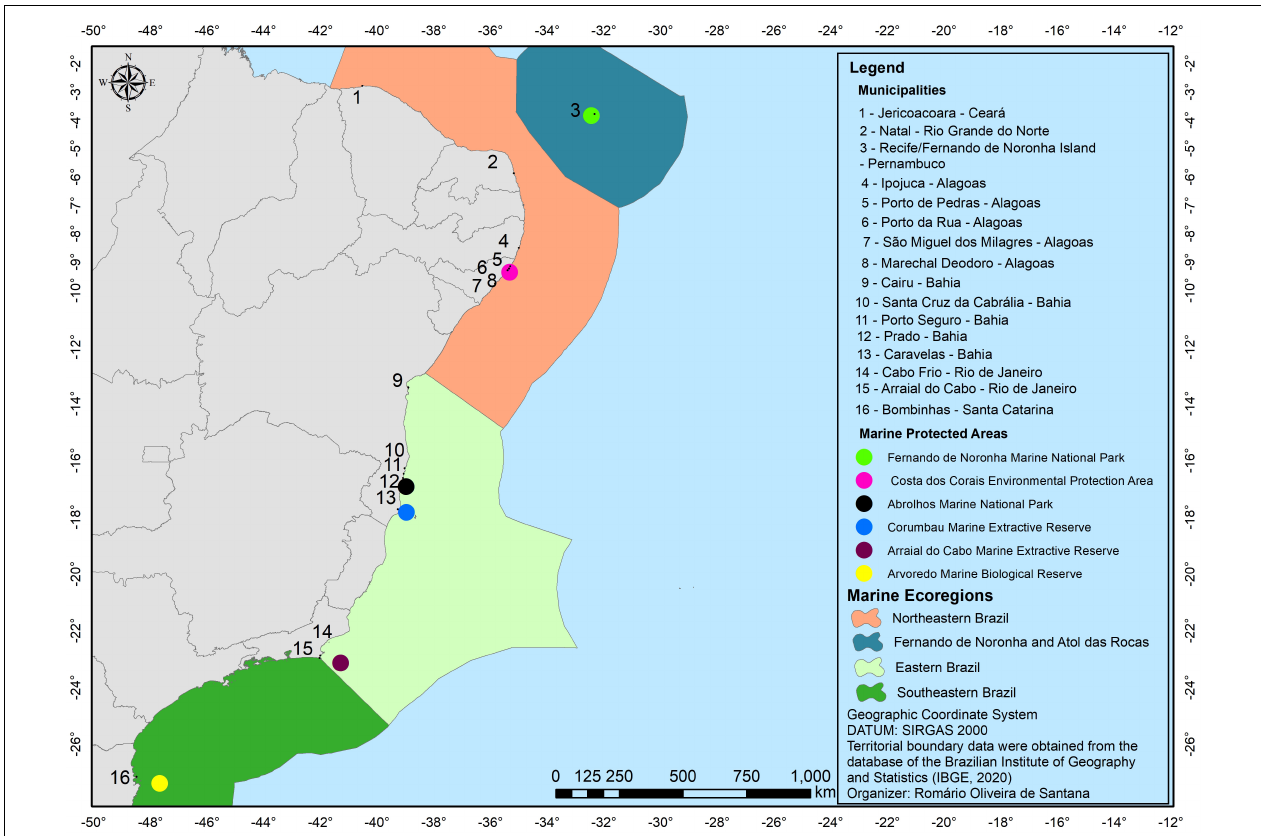
FIGURE 1 | Study area showing the limits of occurrence of Callistoctopus furvus on the Brazilian coast: northern limit (1), southern limit (16), and Fernando de Noronha island (3); the colored and numbered points from 1 to 16 correspond to the municipalities surrounding the marine protected areas (MPAs), which were visited throughout the study period, identified in the image with colored dots; the outlined areas along the Brazilian coast indicate the Brazilian marine ecoregions, in which these municipalities and MPAs are located.